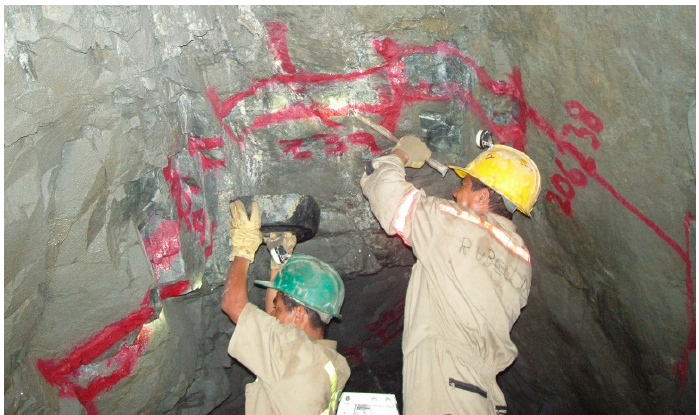
Figure 9. Backs channel sampling in historical workings. A chip-channel is produced, where sample fragments are supposedly being collected in a plastic bowl. In this case the EE is high, as many extracted fragments are not being collected. In addition, DE on the shoulders of the drive is particularly high since the delimited samples are biased within the delimited zone on the curved drive shoulder.